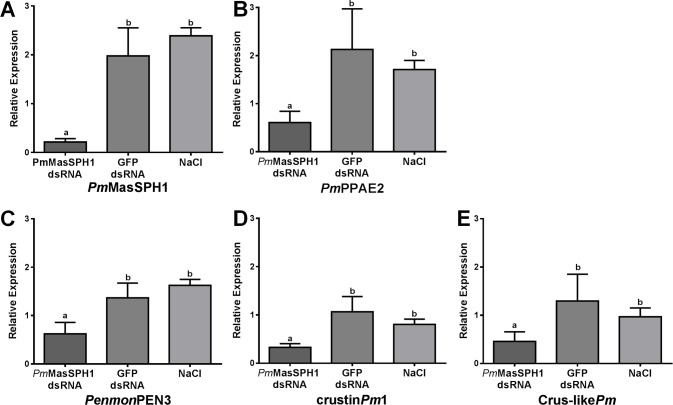
The effect of PmMasSPH1 gene silencing on expression of other immune genes.Transcription levels of PmMasSPH1 (A), PmPPAE2 (B), PenmonPEN3 (C), crustinPm1 (D), and Crus-likePm (E) were analyzed in PmMasSPH1 silenced shrimp and control groups (GFP dsRNA or NaCl treatment). Each transcript is expressed as the relative expression normalized to the EF1-α transcript. Each bar is displayed as the mean ± standard deviation (error bar). The lower case letters represent significant differences between treatments.